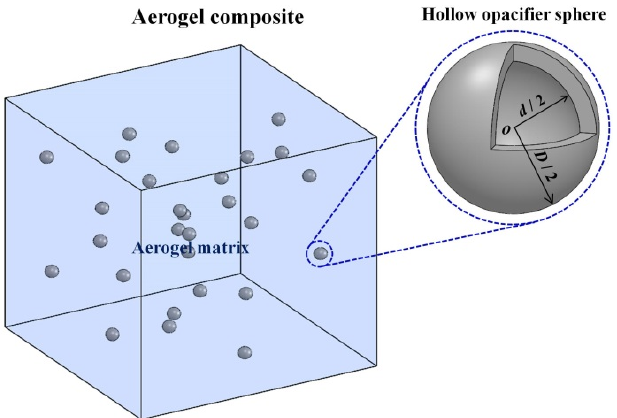
Figure 8. Schematic of silica aerogel composite doped with randomly distributed hollow opacifiers with an outer diameter of 𝐷 and an inner diameter of 𝑑 .